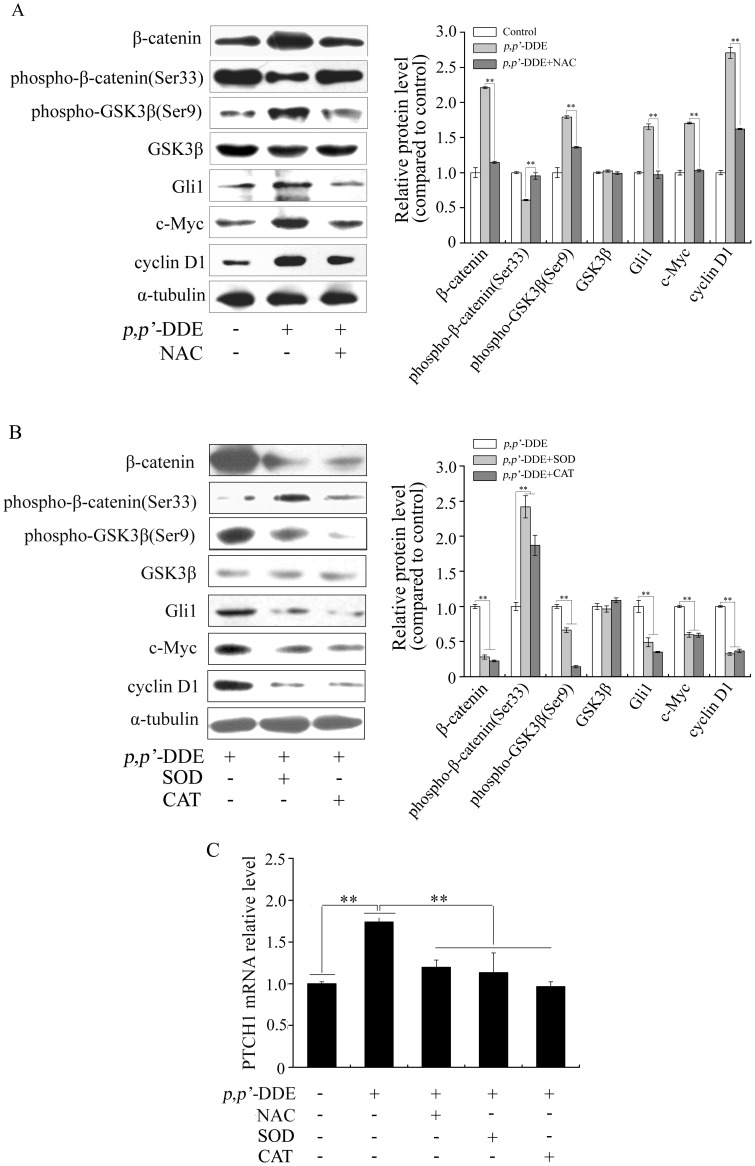
The antioxidants inhibit p,p′-DDE-induced Wnt/β-catenin and Hedgehog/Gli1 signalings activation in DLD1 cells.After DLD1 cells were treated with p,p′-DDE (10−9 M) alone or co-treated with NAC (10−3 M) (A), SOD (100 U/ml) or CAT (500 U/ml) (B) for 96 h, western blotting was performed to analyzed β-catenin, phospho-β-catenin (Ser33), phospho-GSK3β (Ser9), GSK3β, Gli1, c-Myc and cyclin D1. α-tubulin was used as the loading control. Grayscale scan analysis of western blot bands were shown in right panel of graph. (C) mRNA expression of PTCH1 was quantified by quantitative real-time PCR analysis. Relative mRNA levels were normalized with control mRNA. In (A), (B) and (C), value shown was given as the ± SD and acquired from three biologically independent experiments. **p<0.01 compared to the cells treated with 10−9 M p,p′-DDE.